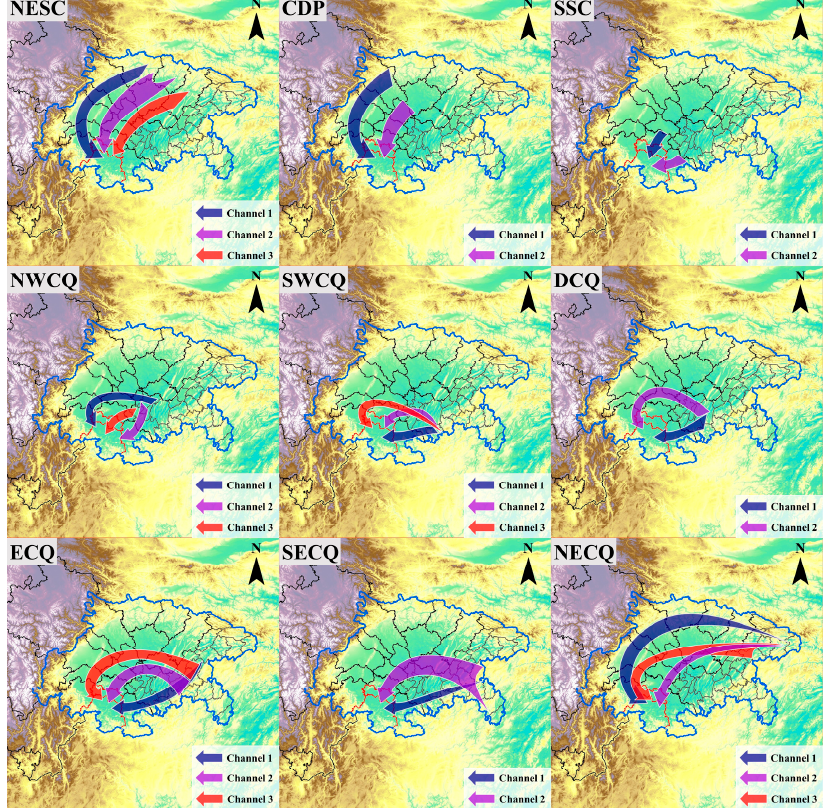
Figure 3. The transport channels a ff ecting the receptor cities originating in the nine urban agglomerations. Table 1. Transport channels of tracer particulates a ff ecting the receptor cities originating in di ff erent urban agglomerations of SCB.